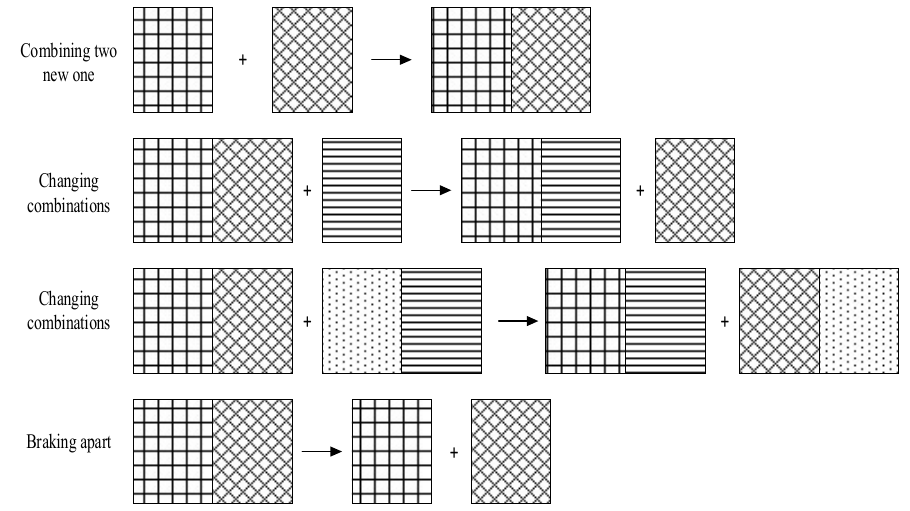
Figure 3. Chemical reaction sorts depicted in schematic form. Atoms and molecules constantly move and clash in a viscous fluid that fills a two- dimensional cell space. Atoms are subatomic particles with mass, radius, charge, direction, location, and velocity. A molecule is a collection of atoms held together by bonds. The mapping of discrete cell configurations to the application of parameters to atoms is a chemical reaction operation. Actions allow bonding and non-bonding to build and break down molecules, create and destroy atoms, orient, change type, and drift. Time proceeds in discrete steps. In short, reactions are obtained by the fractionation of atoms. The encod- ing technique of our load-balancing approach for depicting search nodes as molecules is presented in this section. Any molecule should be able to select a timetable independently. Furthermore, the original molecular population’s quality is increased to improve the chances of obtaining a globally optimum solution. Eventually, the first molecular population algorithm is given. A solution T of the executive order is encoded as an integer queue, where an integer depicts a recycling task ID, i.e., T = { t 1 , t 2 , . . . , t i , . . . , t n }, as shown in Figure 4.